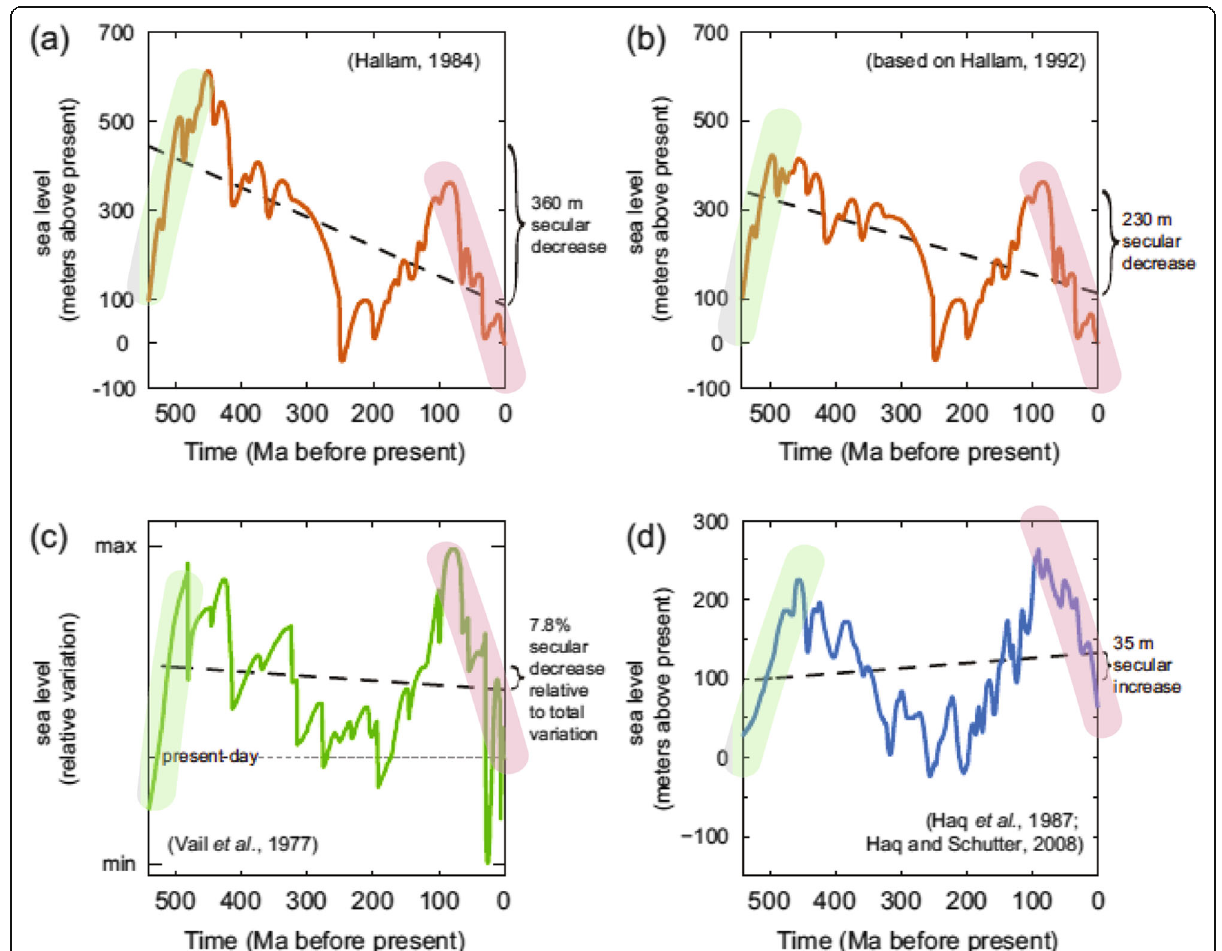
Fig. 6 Sea-level change during the Proterozoic (after Parai and Mukhopadhyay 2012). The sea-level variations show large fluctuations, yet an average sea-level changes only weakly with time (hatches are added by the present authors to emphasize the short-term